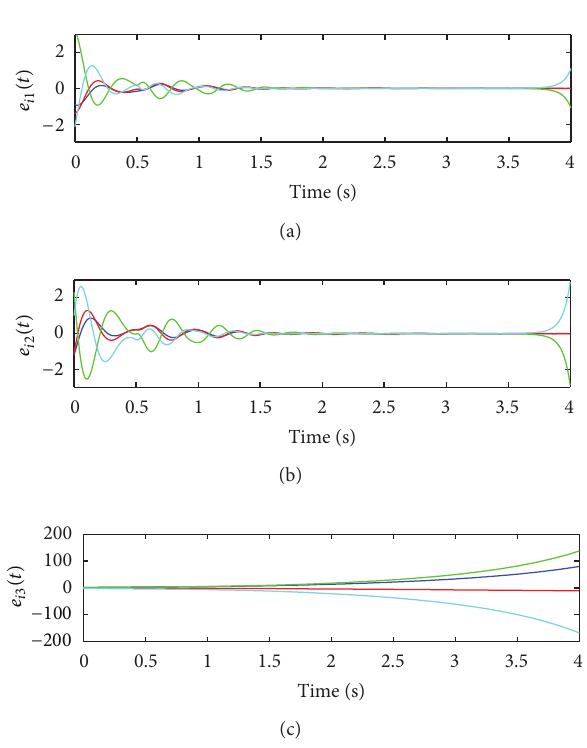
Figure 8: Synchronization errors between the states of node 𝑖 and node 𝑖 + 1 for the non-synchronizable subnetwork (75).